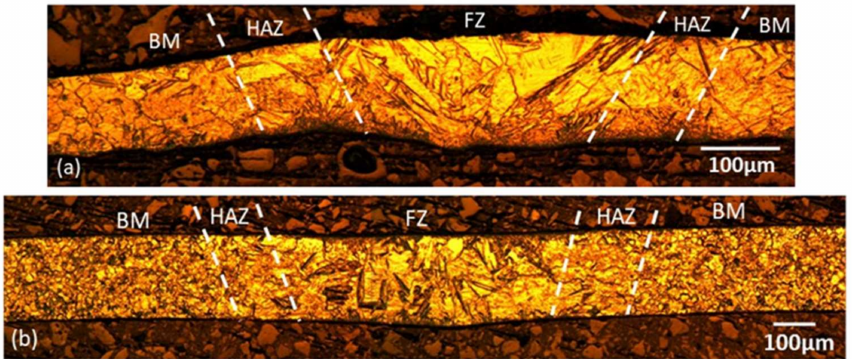
Figure 4. Optical micrographs showing weld profiles: ( a ) 100 µ m thick welded with 50 W of power and at a speed of 20 mm/s, and ( b ) 200 µ m thick welded with 100 W of power and at a speed of 30